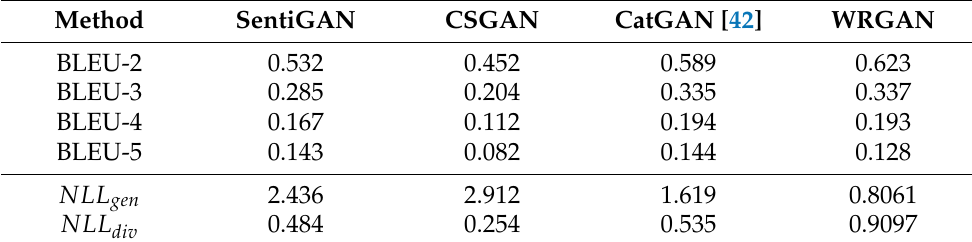
Table 5. The BLEU and NLL scores for the Movie Reviews dataset with Dimension = 128. For BLEU scores and NLL div , the higher the better. For NLL gen , the lower the better.